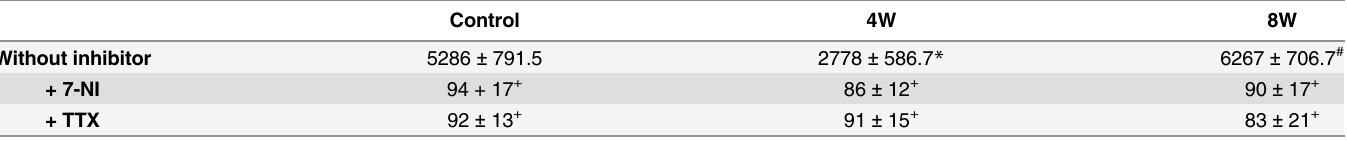
Results (means ± S.E.M.) are expressed in arbitrary units (A.U.)/mg tissue. n = 6 – 10 animals each group.